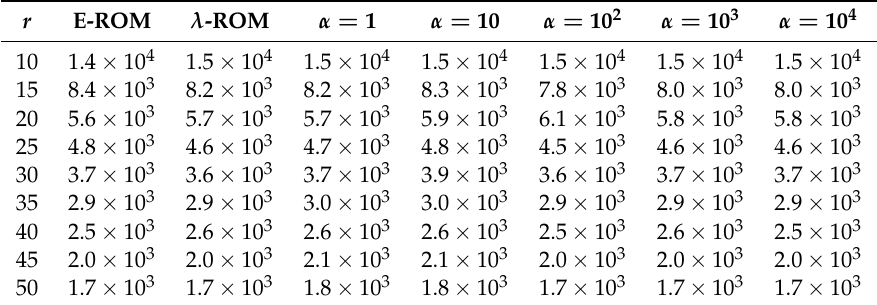
Table 6. Speed-up factors (24) for velocity field computation: E-ROM (second column), λ -ROM (third column), and α -ROM for α = 1 (fourth column), α = 10 (fifth column), α = 10 2 (sixth column), α = 10 3 (seventh column), and α = 10 4 (eighth